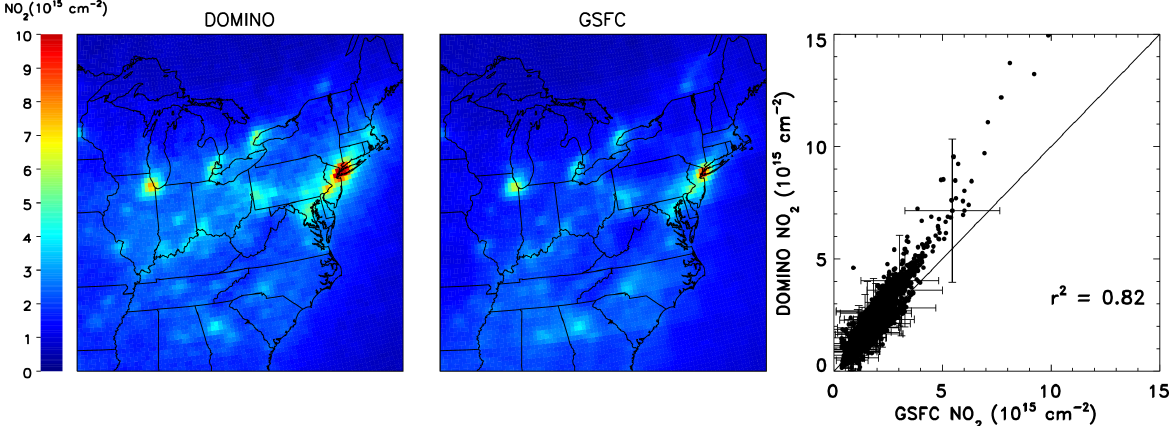
Figure 1. Average OMI tropospheric column NO 2 observations for July and August 2007 for both the DOMINO (left) and GSFC (middle) retrievals. The level 2 swath data for both retrievals have been screened, weighted based on viewing angle and gridded onto a 0 . 25 ◦ × 0 . 25 ◦ lat/lon grid. Only observations where cloud fraction is less than 30% are used in the gridding process. Both data sets indicate that the highest levels of tropospheric NO 2 occur over urban regions. A scatter plot of DOMINO vs. GSFC observations (right) indicates that the DOMINO retrieval is roughly 20% higher, on average, than the GSFC satellite product. Error bars indicate the uncertainty in the satellite